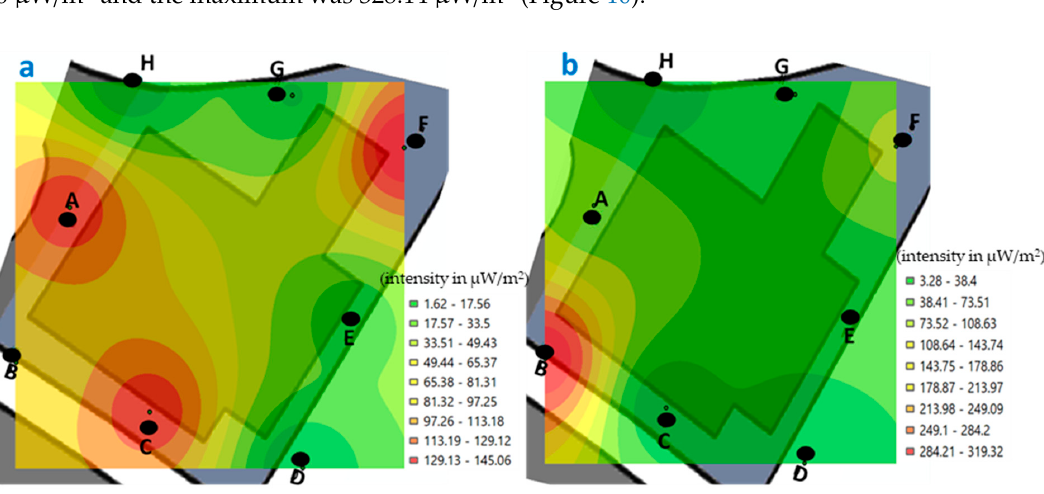
Figure 9. Georeferenced map with the levels of exposure registered in the H building (professors’ offices, points A–H), in the morning. ( a ) weekend and ( b ) during the week ( μ W/m 2 ).